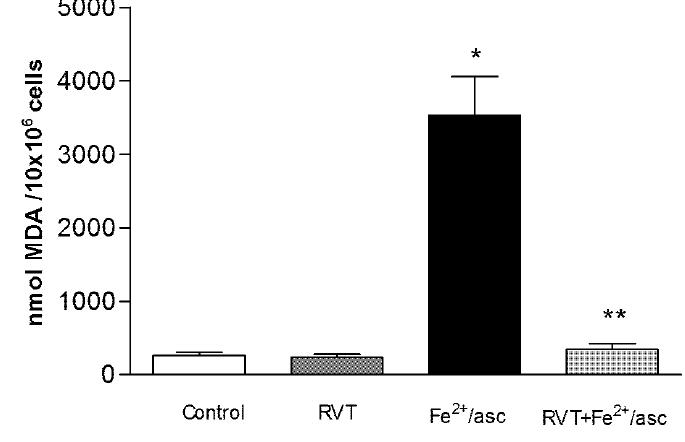
Figure 5. Effect of RVT on lipid peroxidation. Spermatozoa were obtained from ductus deferens in M-16 medium, pooled and incubated with RVT, Fe 2+ /asc or RVT + Fe 2+ /asc. Lipid peroxidation was measured with a spectrophotometer using the TBARS method. Values are the mean ± SD of three independent experiments performed in duplicate.